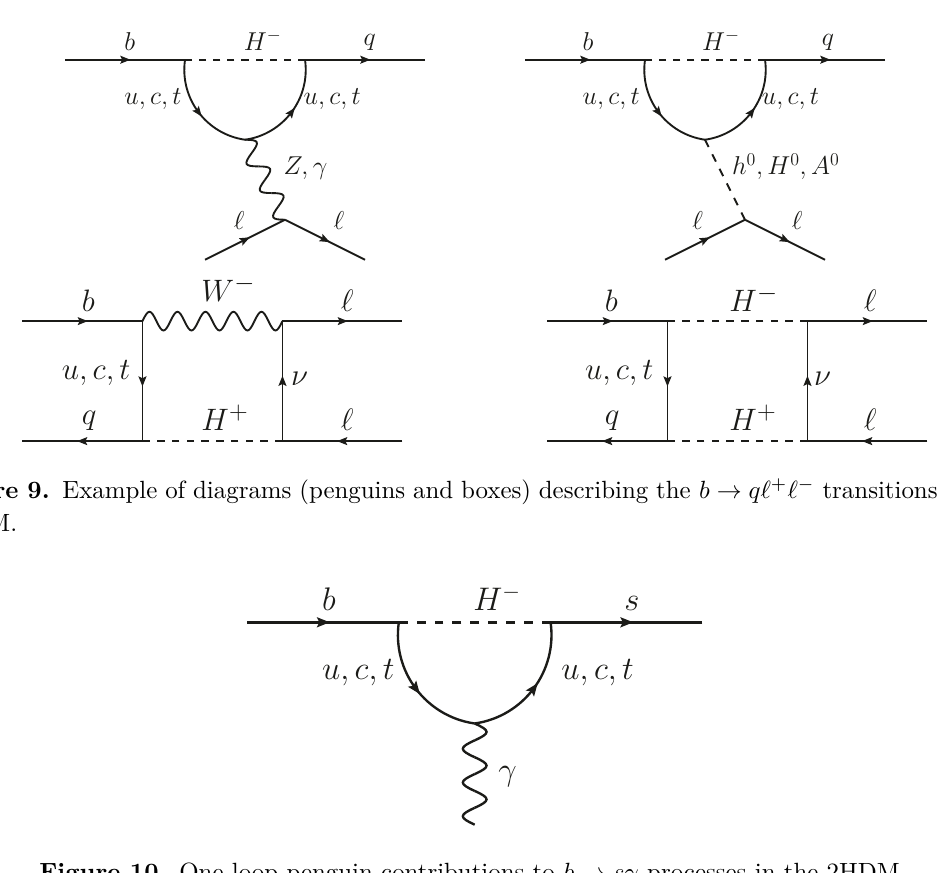
Figure 10. One-loop penguin contributions to b → sγ processes in the